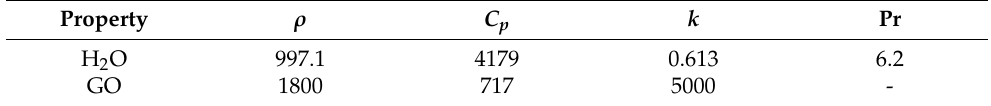
Table 1. Base liquid and nanoparticle thermo-physical characteristics.